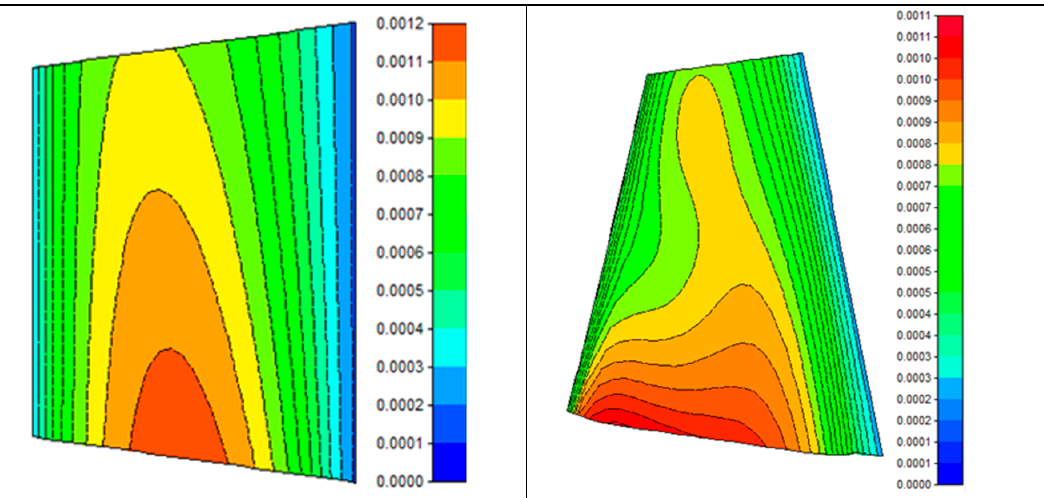
Figure 12. Meridional preliminary blade thickness contours (m) for (left) stator (right) rotor.